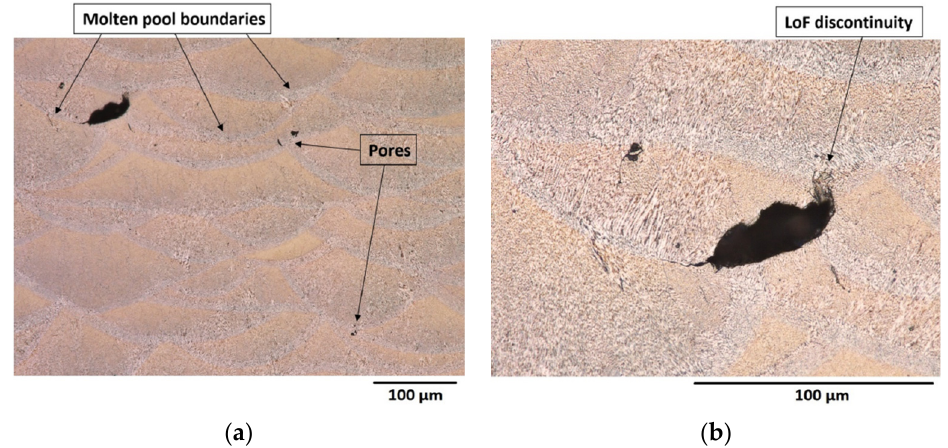
Figure 6. Optical micrograph of lack of fusion (LoF) representative discontinuity; ( a ) 500× and ( b ) 1500× magnifications.